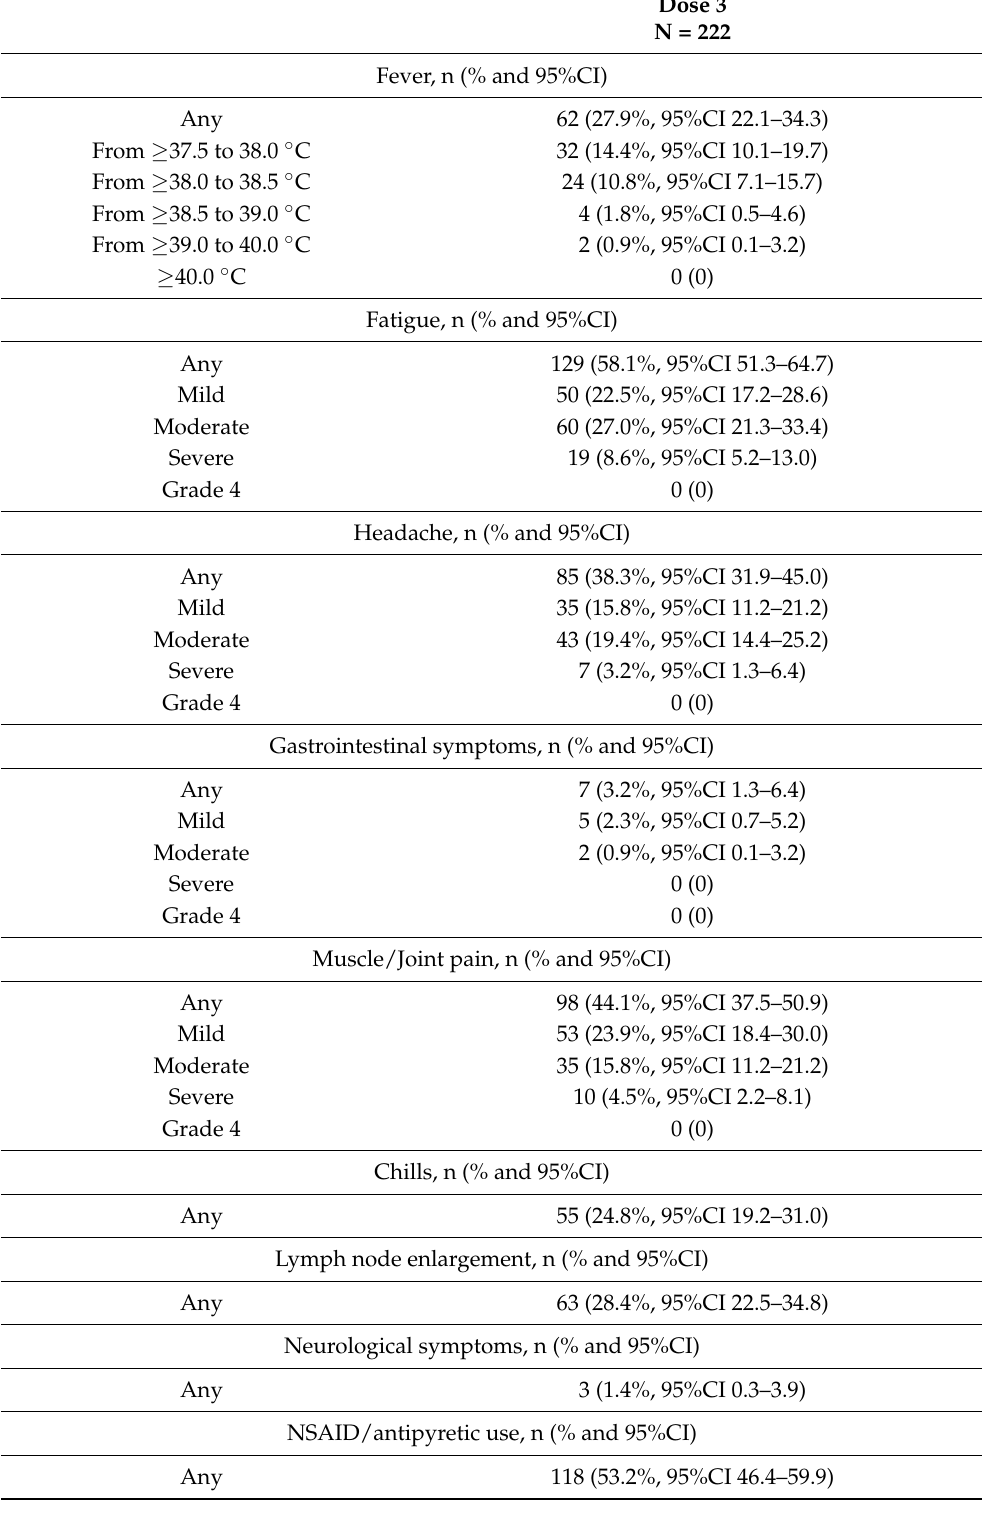
Table 2. Systemic adverse reactions in the 7 days after the third vaccine dose administration, stratified by symptom severity. “Any” represents the overall reporting of the specific adverse